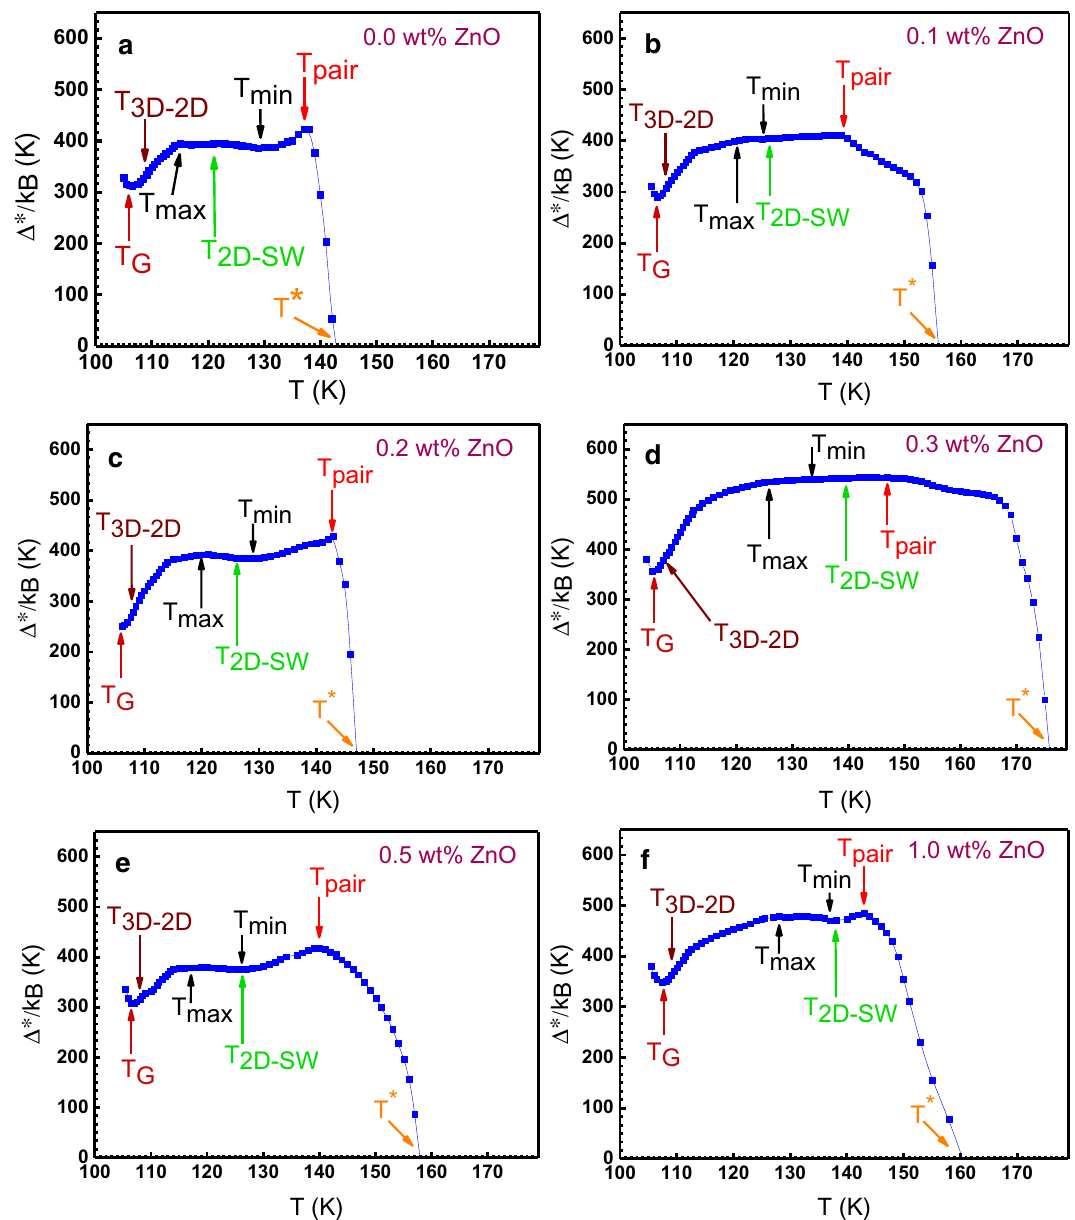
Figure 6. Temperature dependence of the pseudogap Δ*(T) for different (Bi, Pb)-2223/(ZnO NPs)x composites, calculated by local pairs model. The arrows represent characteristic temperatures. The solid lines are to guide the